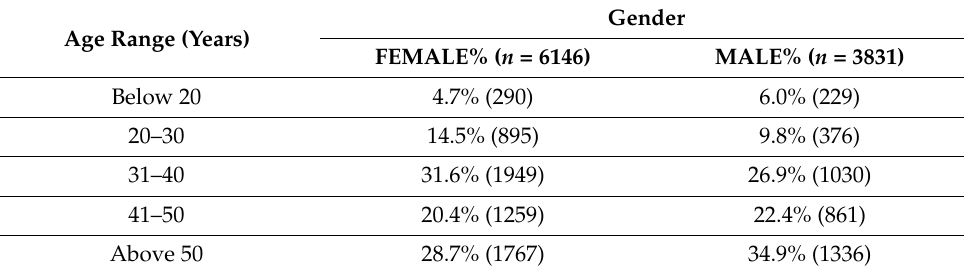
Table 1. Gender and age subgroup of the study population.